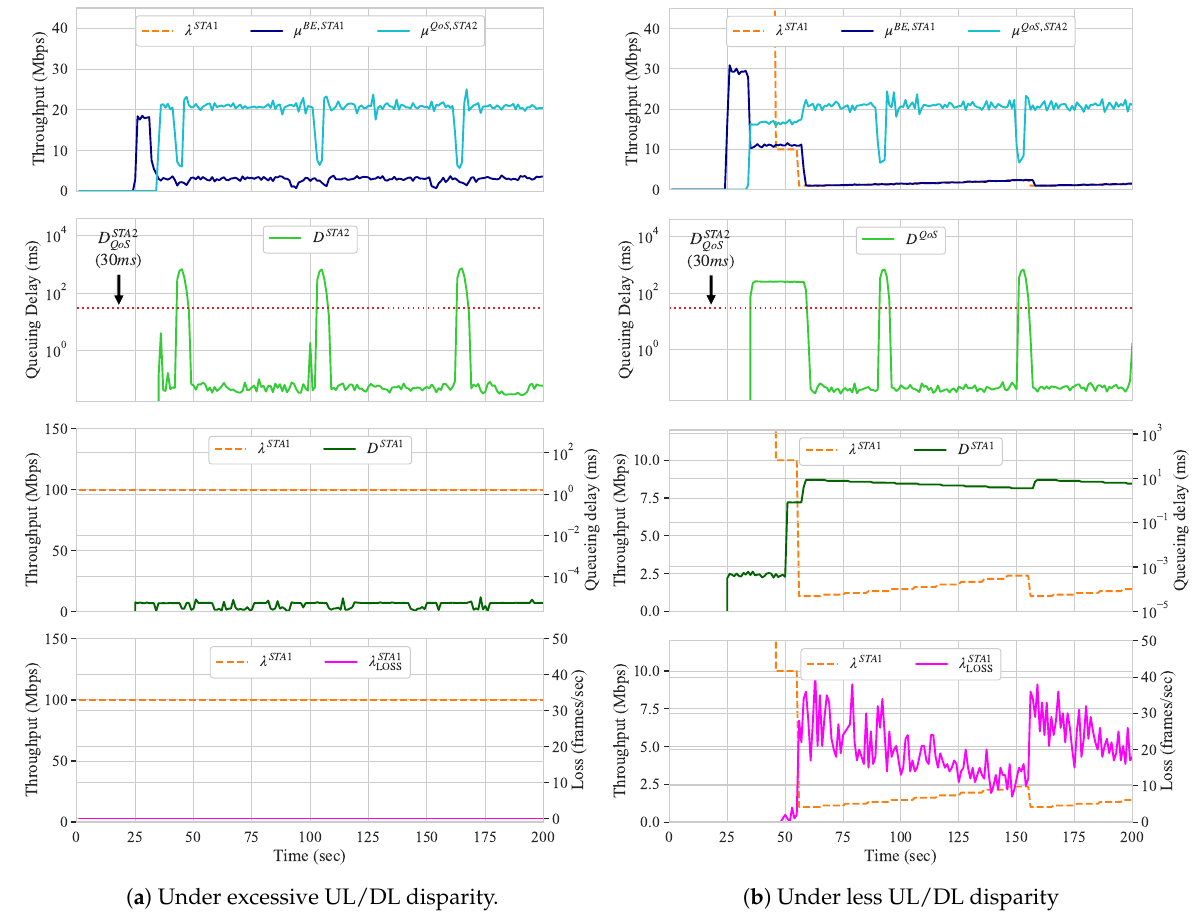
Figure 8. Scenario